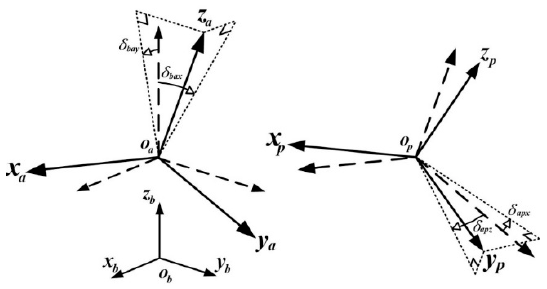
Figure 9. The axis perpendicularity deviations.